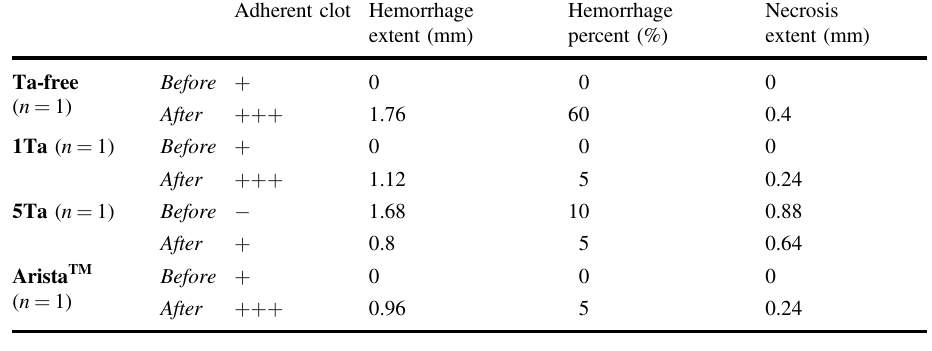
Fig. 4 Histopathological evaluation. Histology images of the liver tissue: a and b show the presence and absence of adherent clots at 10×; c and d show hemorrhage extent at 50×; e and f show the necrosis extent at 100×. a Liver tissue displays no adherent clot ( − ) before the intervention; no dark reddish stains representing adherent clots are seen. b Liver tissue shows extensive adherent clot ( +++ ) following hemostatic interventions; abundant dark reddish stained tissue (arrows) means adherent clot. c Liver tissue does not show any bleeding at the start of the procedure; d Liver parenchyma shows 60% hemorrhage with an extent of 1.76 mm; redness in the interstitial parenchyma (arrows) is representative of the bleeding. e Liver tissue does not show any necrosis at the start of the procedure; f represents a maximum necrosis extent of the liver tissue seen in the study; light pink stained tissue (arrows) represents the necrotic areas while red-stained area shows hemorrhage associated with the